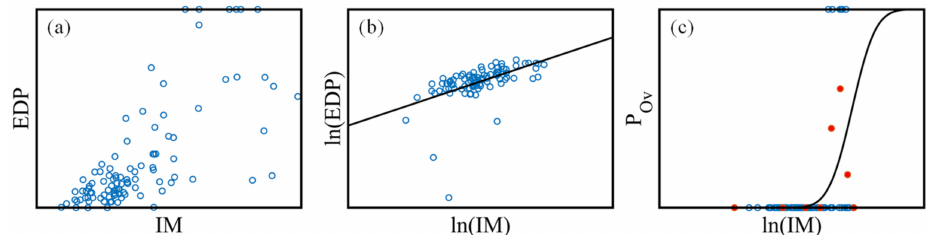
Figure 2. Computational scheme of vulnerability analysis: ( a ) time history analyses results, ( b ) PSDM of the finite rocking responses, and ( c ) MLE for overturning probability parameters.